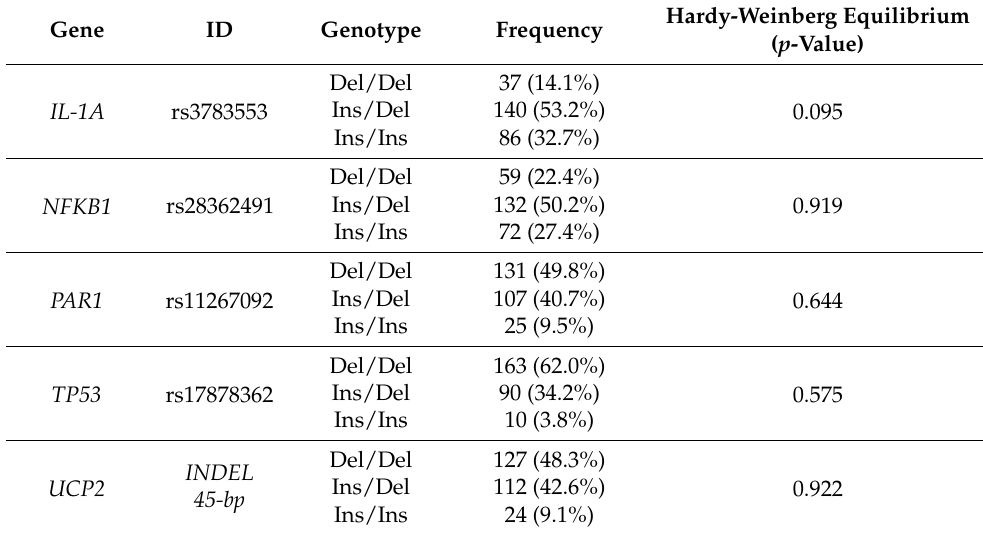
Table 2. Hardy–Weinberg equilibrium of the investigated genetic